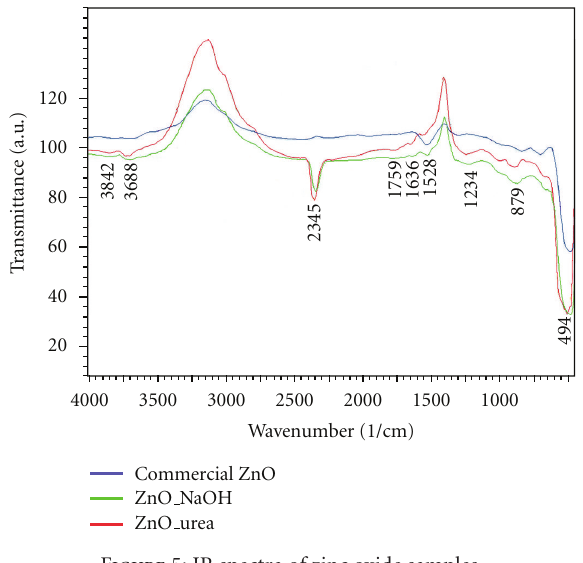
Figure 5: IR spectra of zinc oxide samples.